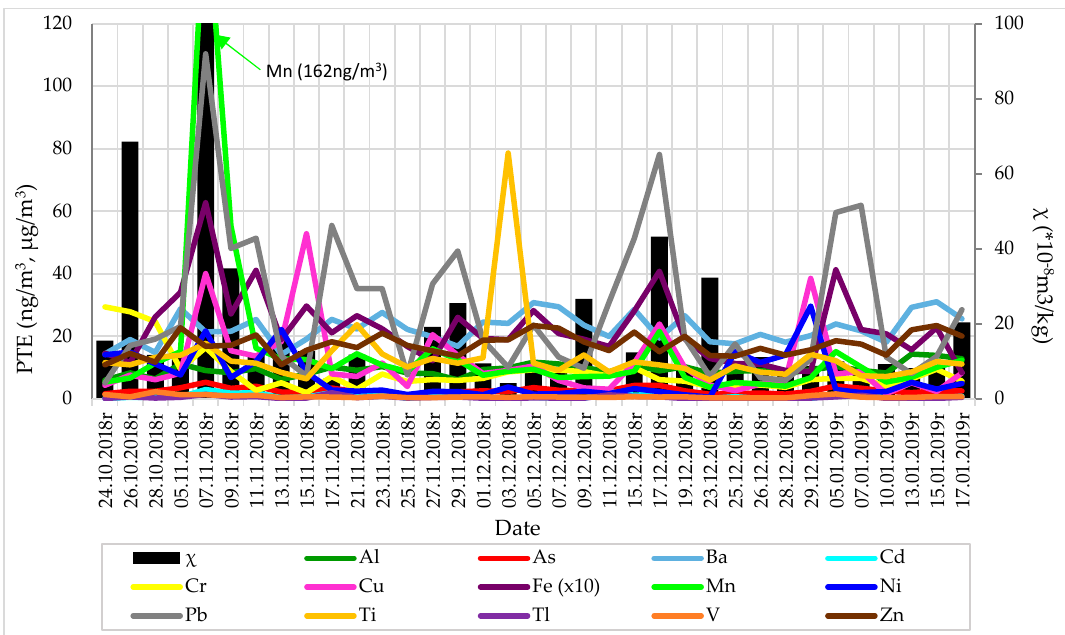
Figure 3. Mass-specific magnetic susceptibility ( χ ) and concentration of PTE ((As, Cd, Cr, Cu, Fe [×10], Mn, Ni, Pb, Ti, Tl and V in ng/m 3 ) and (Al, Ba and Zn in µg/m 3 )) in TSP daily filters.